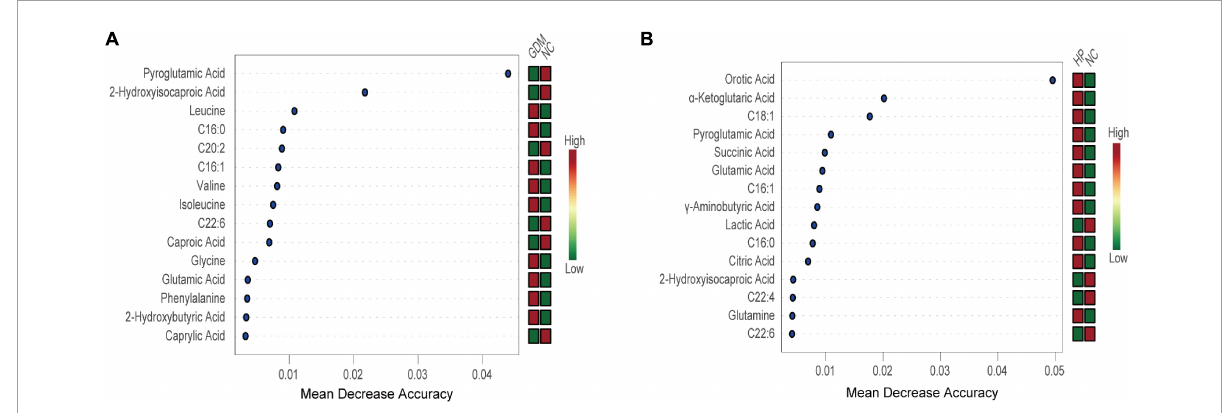
FIGURE3 Random Forest revealed the 15 most important metabolites for NC vs. GDM (A) and for NC vs. HP (B) . Mean decrease accuracy is higher, and the impact of metabolites on GDM/HP is larger. The figure on the right is a heat map of the identified 15 metabolites in both groups. Red is high-expression; green is